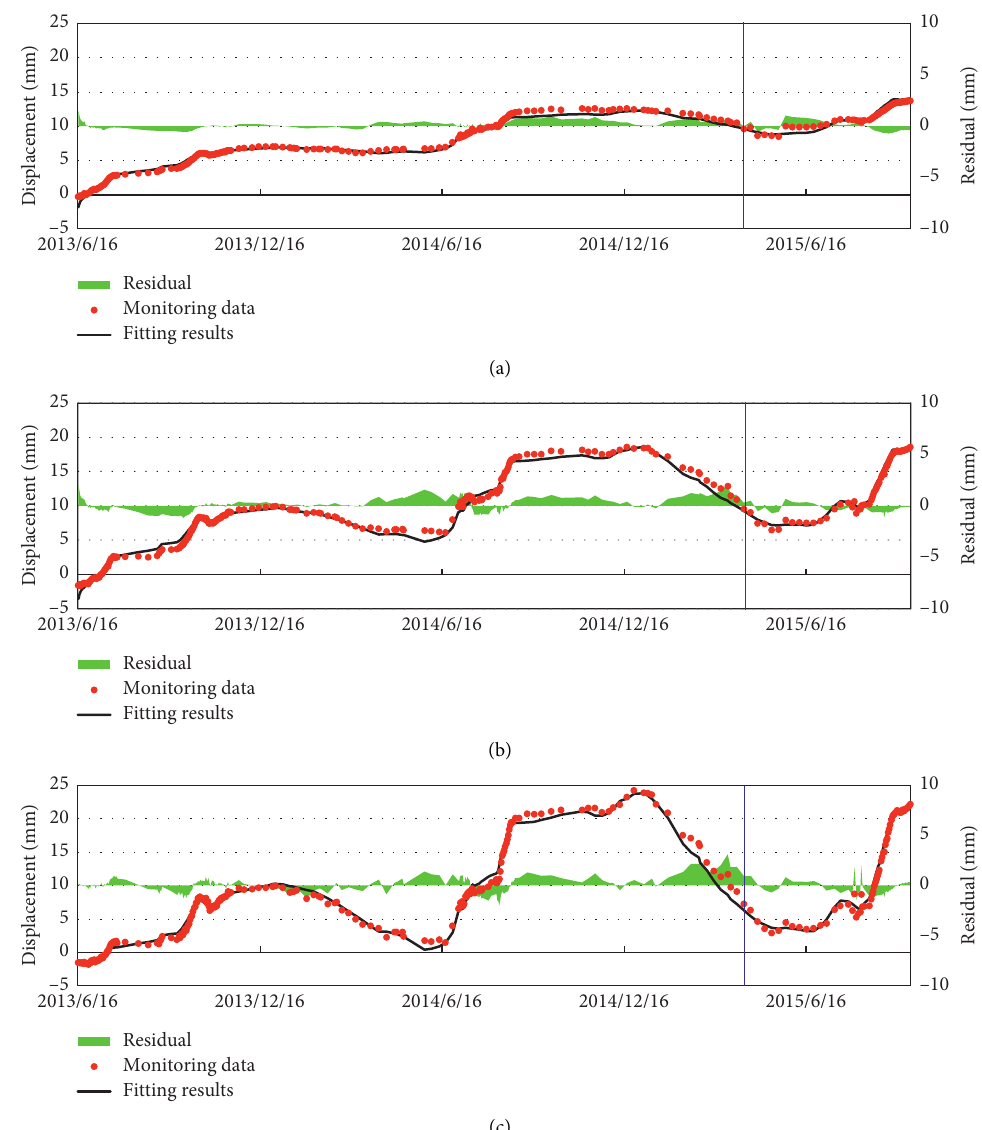
Figure 11: Modeling results for monitoring points located at vertical line 5#: (a) PL5-4, (b) PL5-3, and (c)